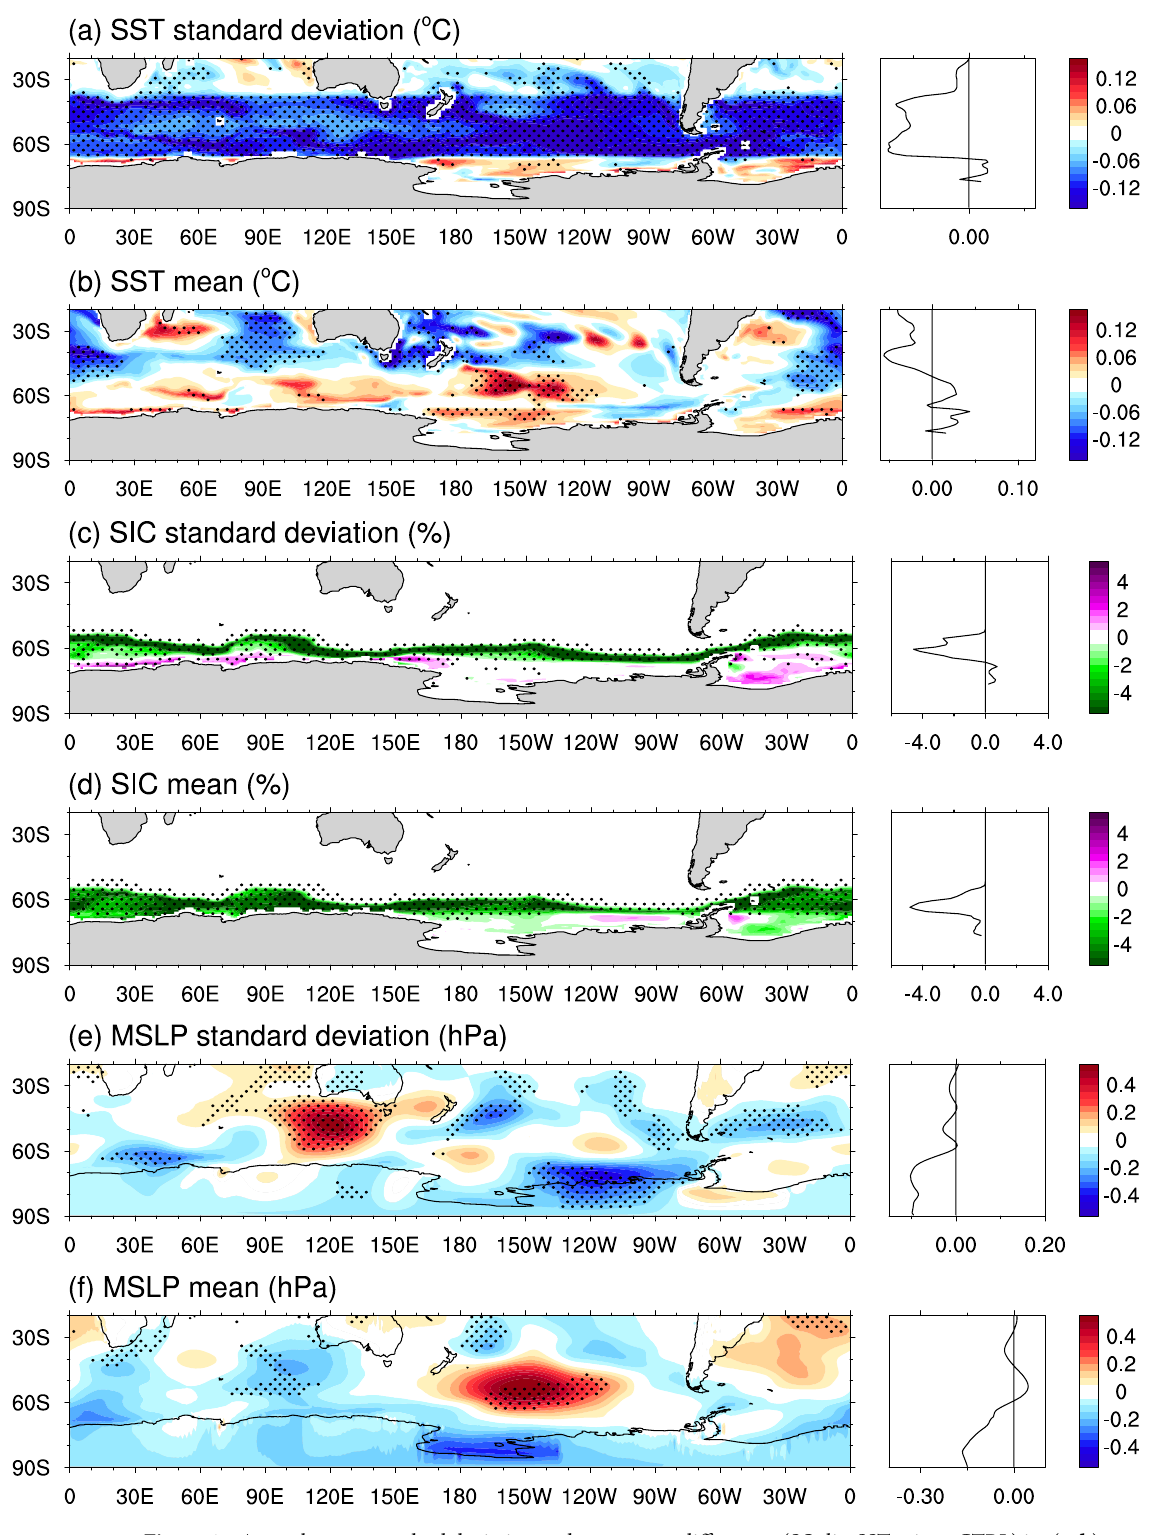
Figure 1. Annual-mean standard deviation and mean-state differences (SOclimSST minus CTRL) in: ( a , b ) SST, ( c , d ) SIC, and ( e , f ) MSLP. Stippling indicates robustness in the sign of the ensemble-mean difference, where the sign of all six individual differences (each SOclimSST run minus each CTRL run) is the same. Zonal mean panels are shown to the right of map panels. Figure produced using the NCAR Command Language (https:// doi. org/ 10. 5065/ D6WD3